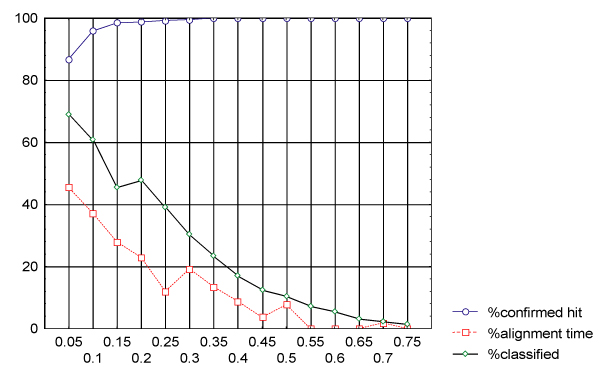
Effect of stringency threshold parameter variation. Stringency threshold affects the percentage of similarities confirmed by alignment, relative time spent on pair-wise alignment and percentage of initial ESTs assigned to clusters (non-singletons).